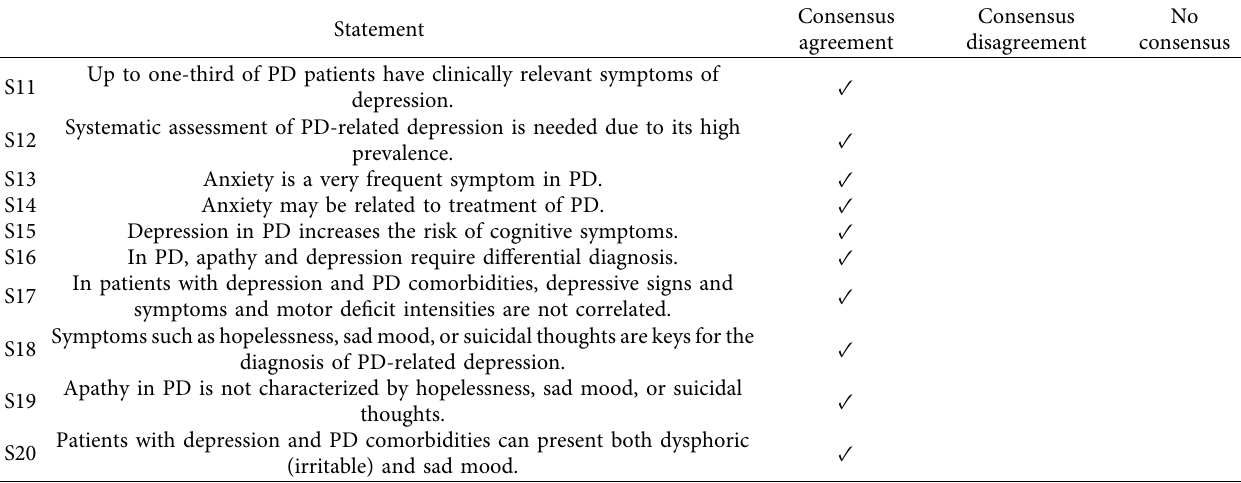
Table 2: Section II: clinical presentation of depression in PD patients.